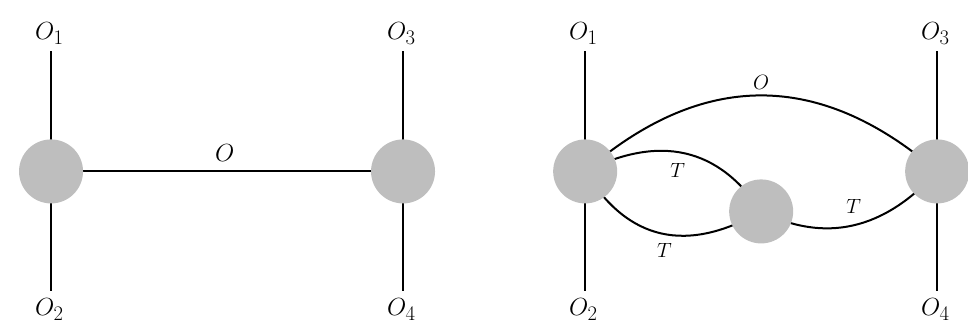
Figure 2. Feynman diagrams corresponding to the exchange of a primary operator O and its